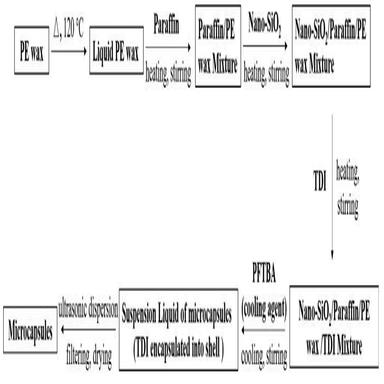
Preparation procedure of nano-SiO2/paraffin/PE wax composite shell microcapsules.